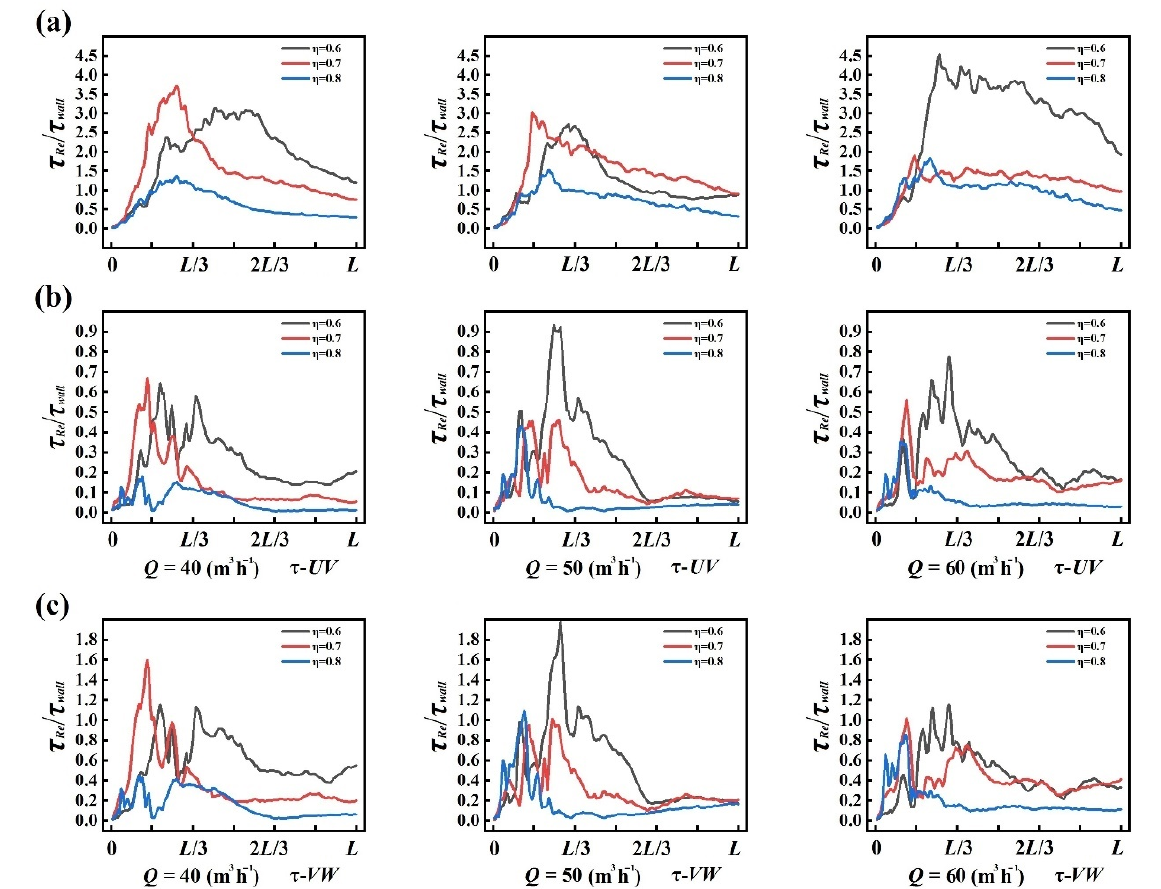
Figure 3. Reynolds stress of a meridian section along the flow: ( a ) the Reynolds stress τ - UW at three flows; ( b ) the Reynolds stress τ - UV at three flows; ( c ) the Reynolds stress τ - VW at three flows. The Reynolds stresses are nondimensionalized by the wall shear stresses.